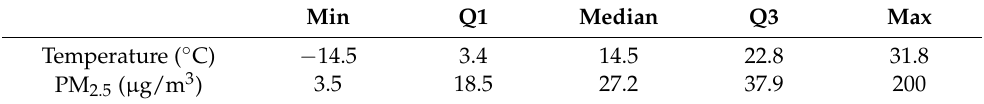
Table 2. Quartiles of daily mean temperature ( ◦ C) and PM 2.5 ( µ g/m 3 ) in Seoul between 2009 and